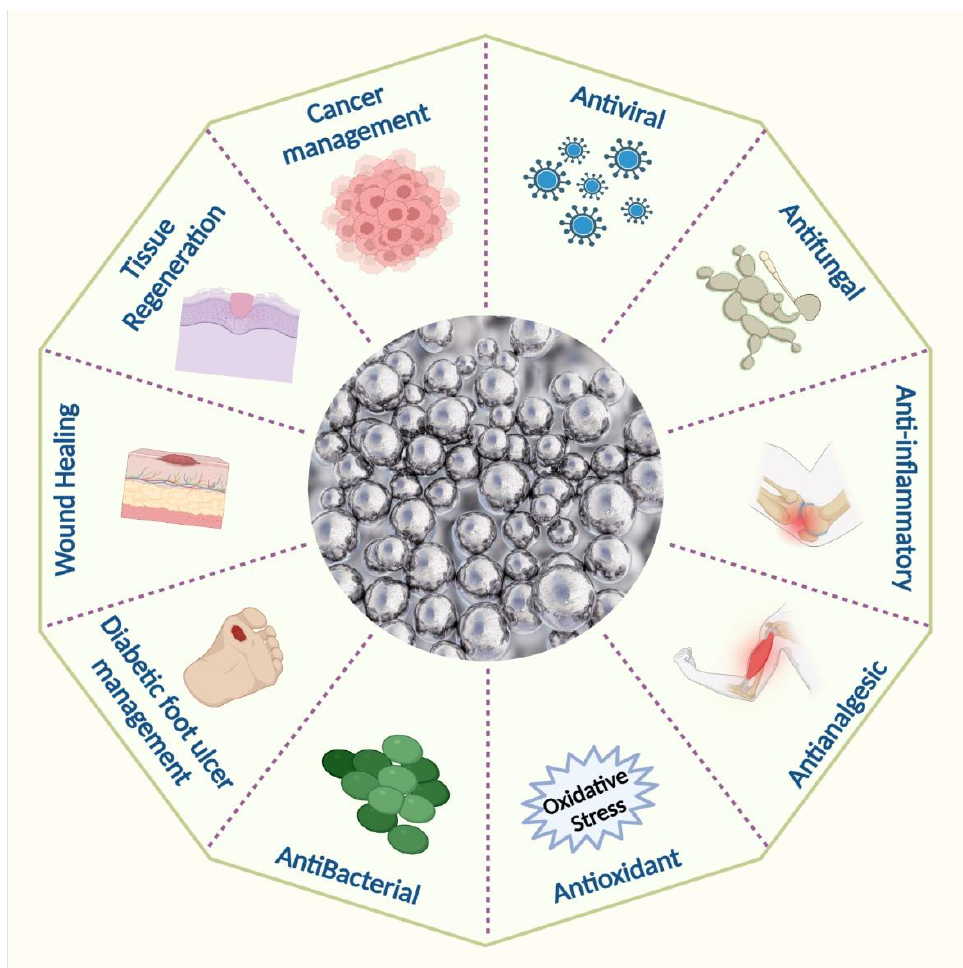
Figure 3. Biomedical applications of silver nanoparticles.